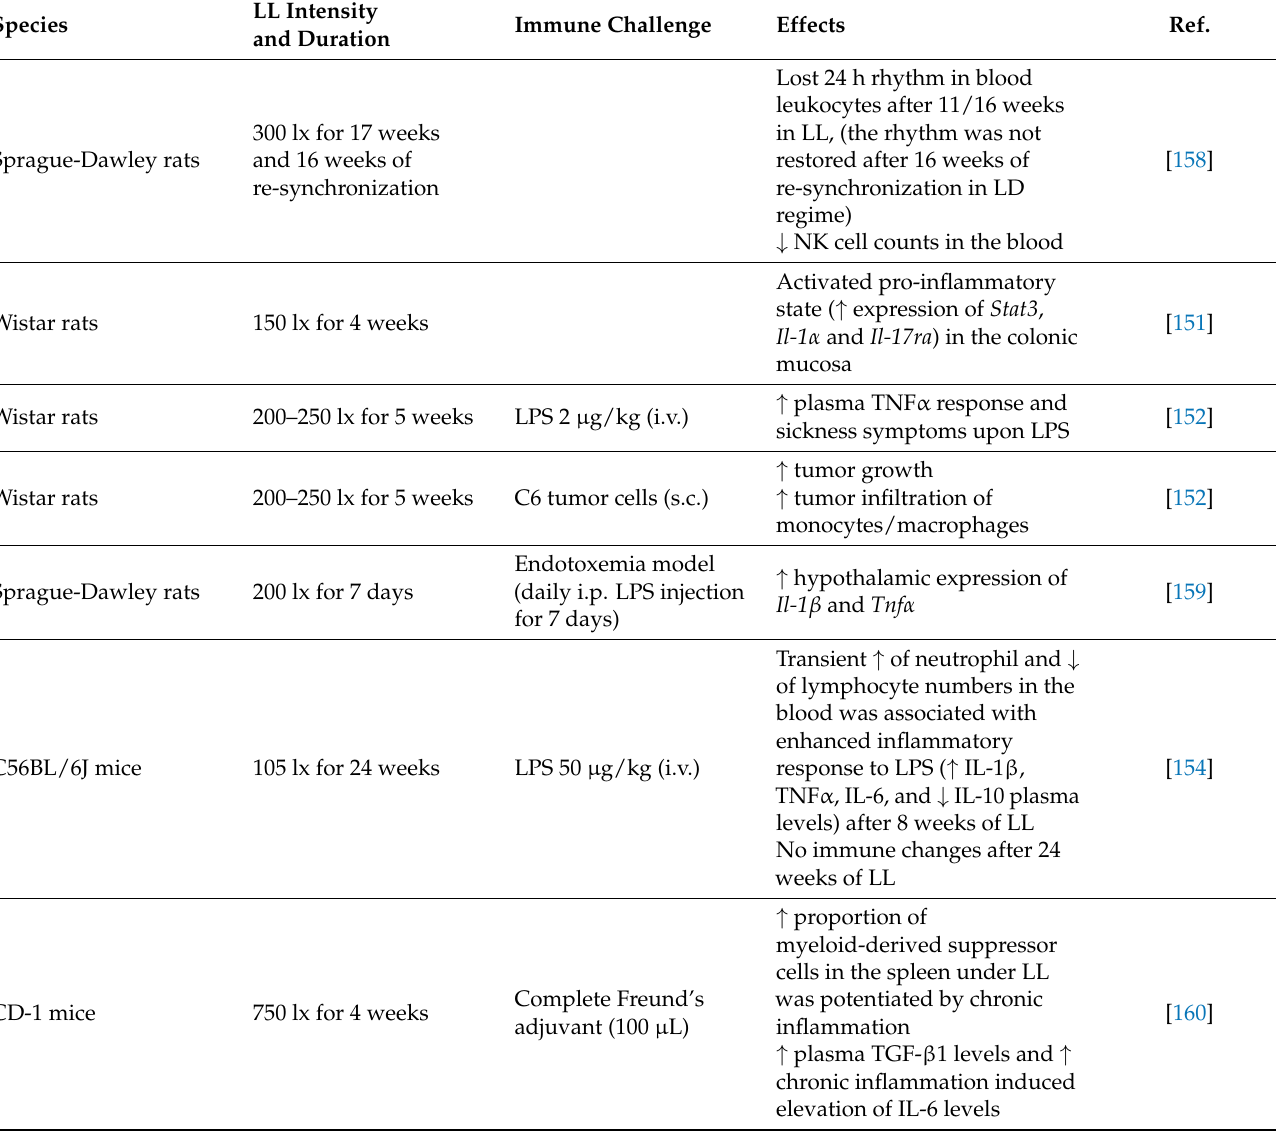
Table 4. Summary of the effects of constant light (LL) on the immune parameters under steady state and challenged conditions in